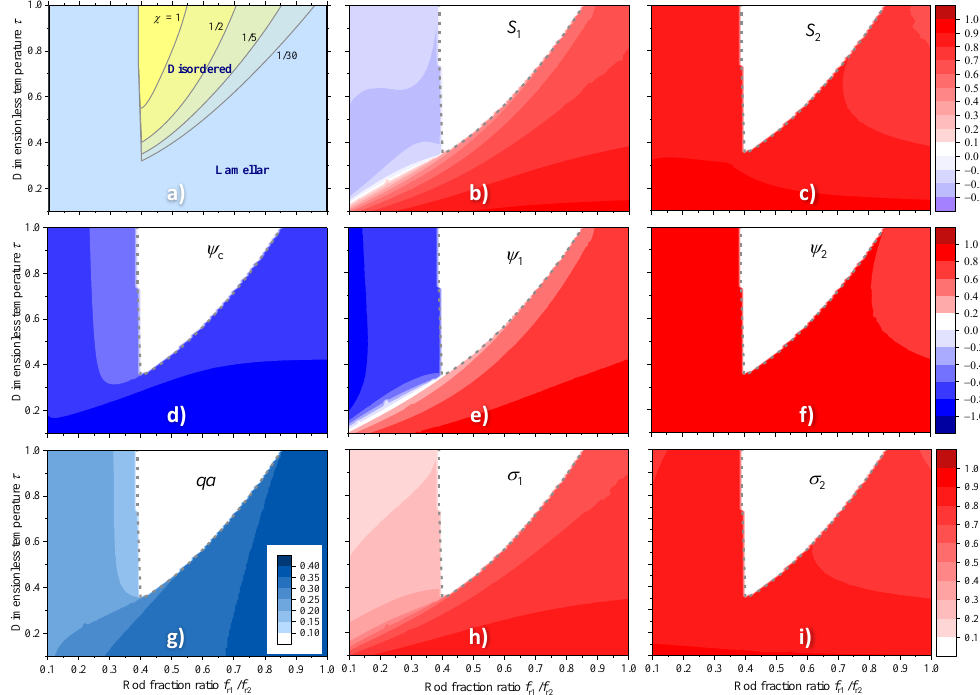
Figure 1. Phase diagrams, order parameters and equilibrium wavenumber in the axes of rod fraction ratio f r 1 / f r 2 —dimensionless temperature τ = k B T / J 0 of asymmetric rod-coil-rod triblock copolymer calculated numerically by minimizing the free energy (17) for N = 30, J 2 = 2 J 0 and f c = 0.5. Phase diagrams for different indicated values of the Flory-Huggins parameter χ are shown in ( a ). The colormaps ( b – i ) are calculated for χ = 1/5 and represent the variation of orientational ( b , c ), translational ( d – f ) and mixed ( h , i ) order parameters in the lamellar phase. The colormap in ( g ) shows the wavenumber of the lamellar structure.